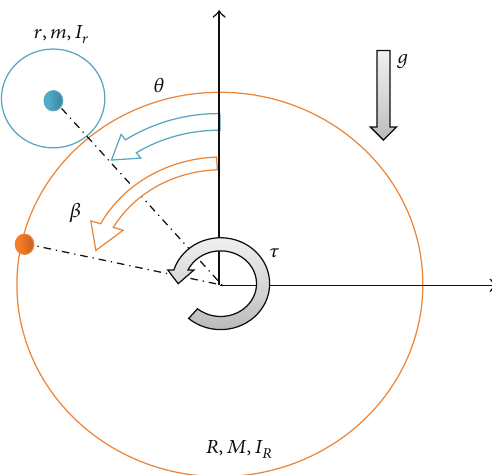
Figure 2: Schema of the ball and wheel system.